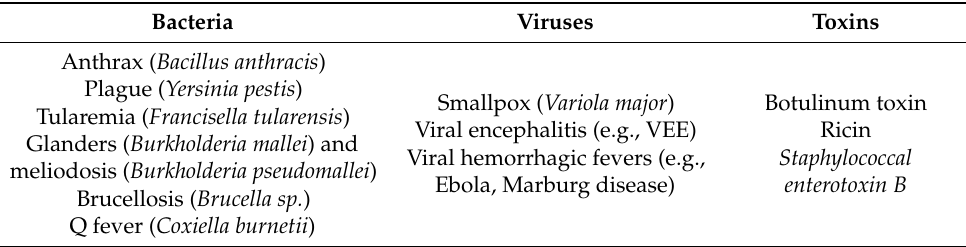
Table 1. Most probable pathogens and toxins to be used as BWAs (“Dirty Dozen”). Adapted with permission from